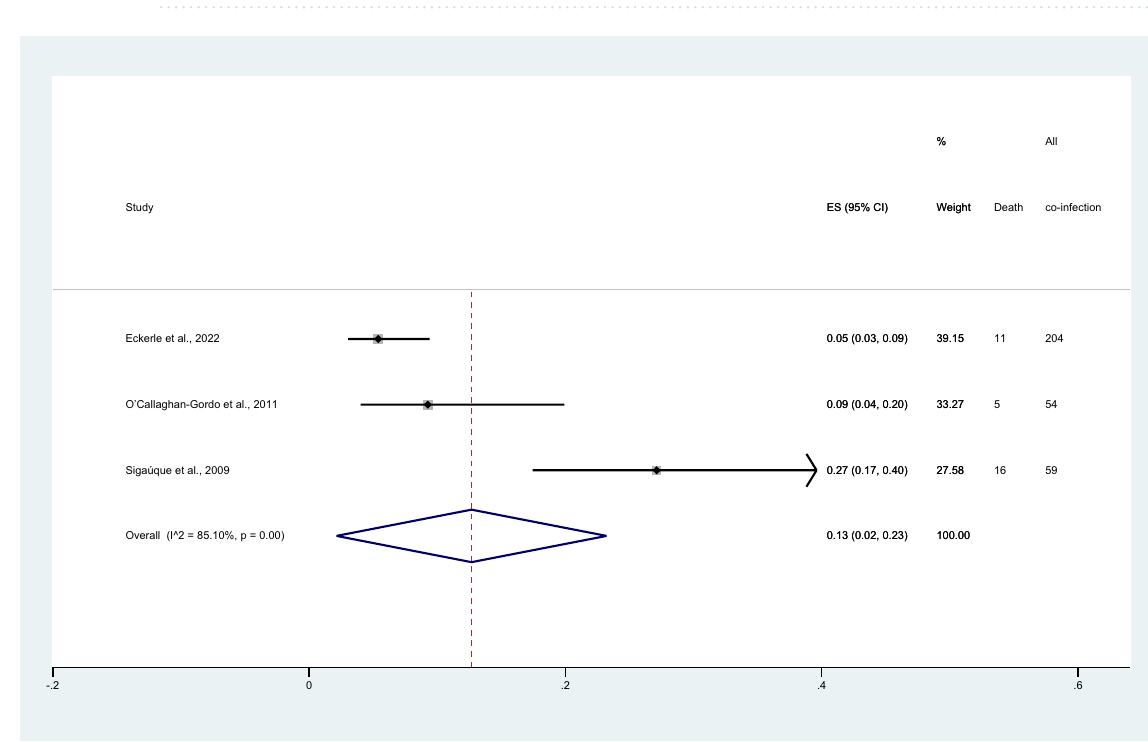
Overall (I^2 = 85.10%, p = 0.00)